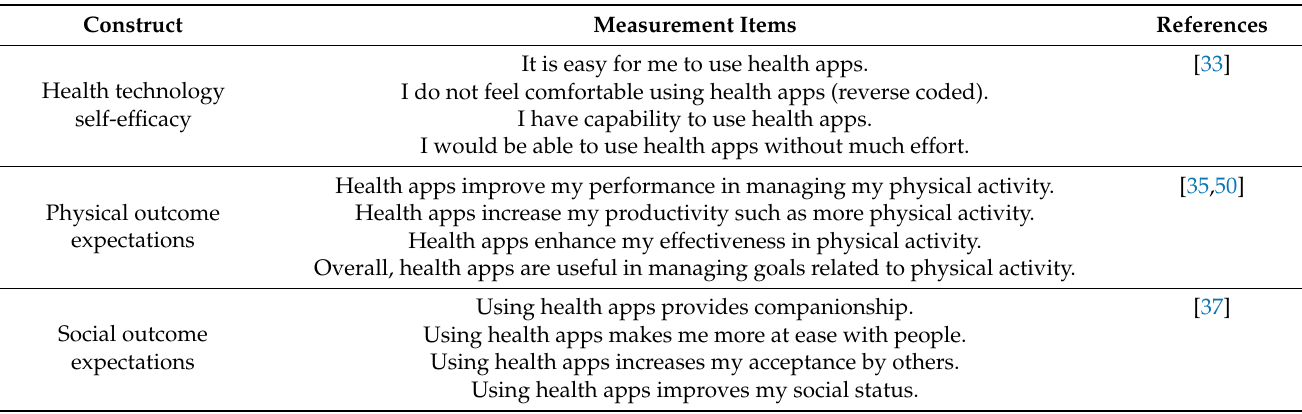
Table A1. Measurement items of the